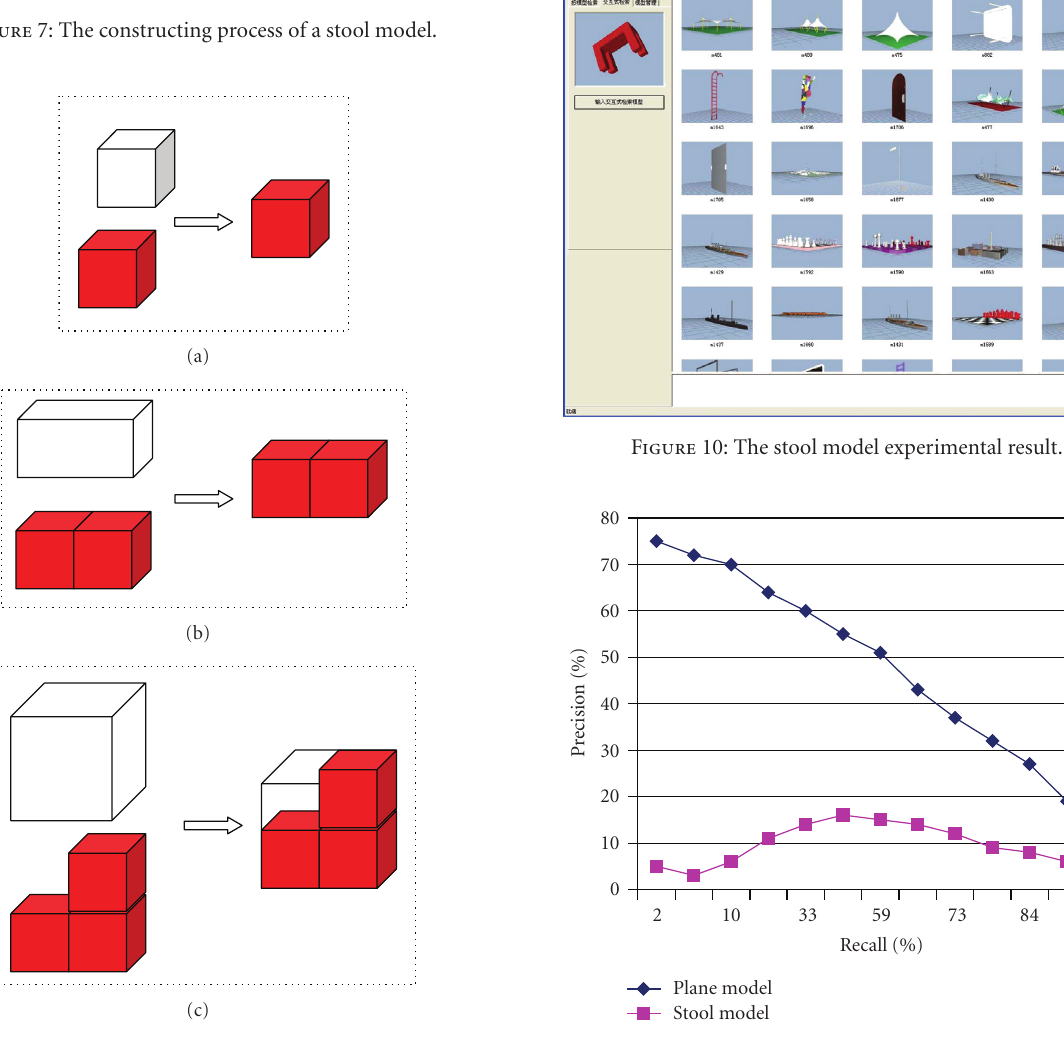
Figure 8: Model of the split-sample map.